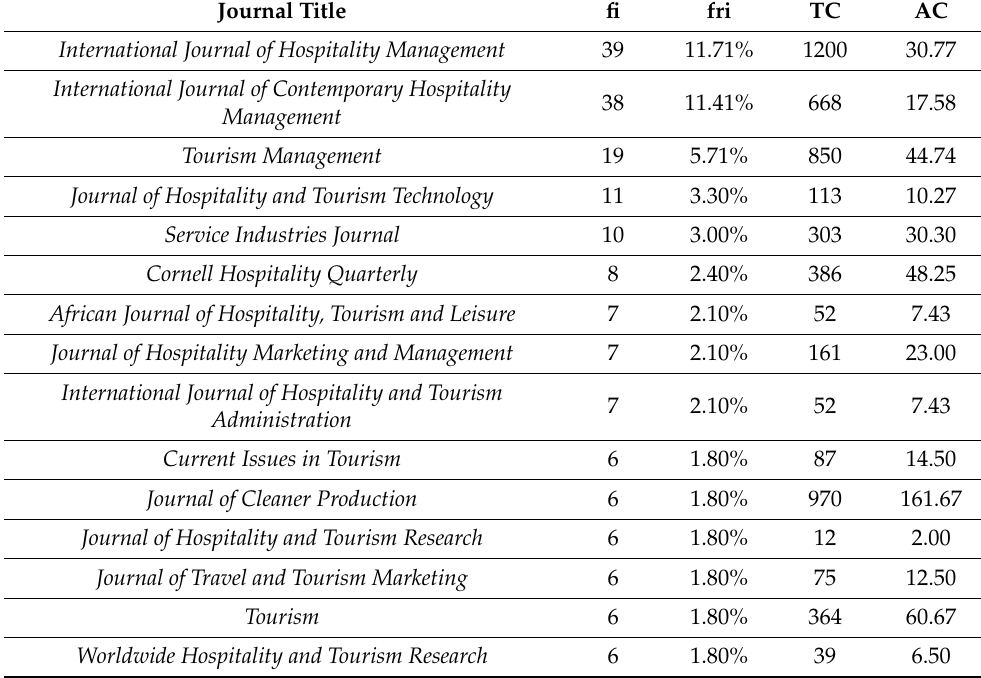
(red cluster), innovativeness and innovation strategy (green cluster), knowledge and em- ployee innovative behavior (blue cluster), and performance as an outcome of organizational capability to innovate (pink